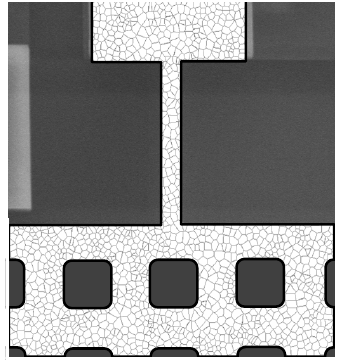
Figure 3. Close-up of an example of (digital) polycrystalline morphology of the movable